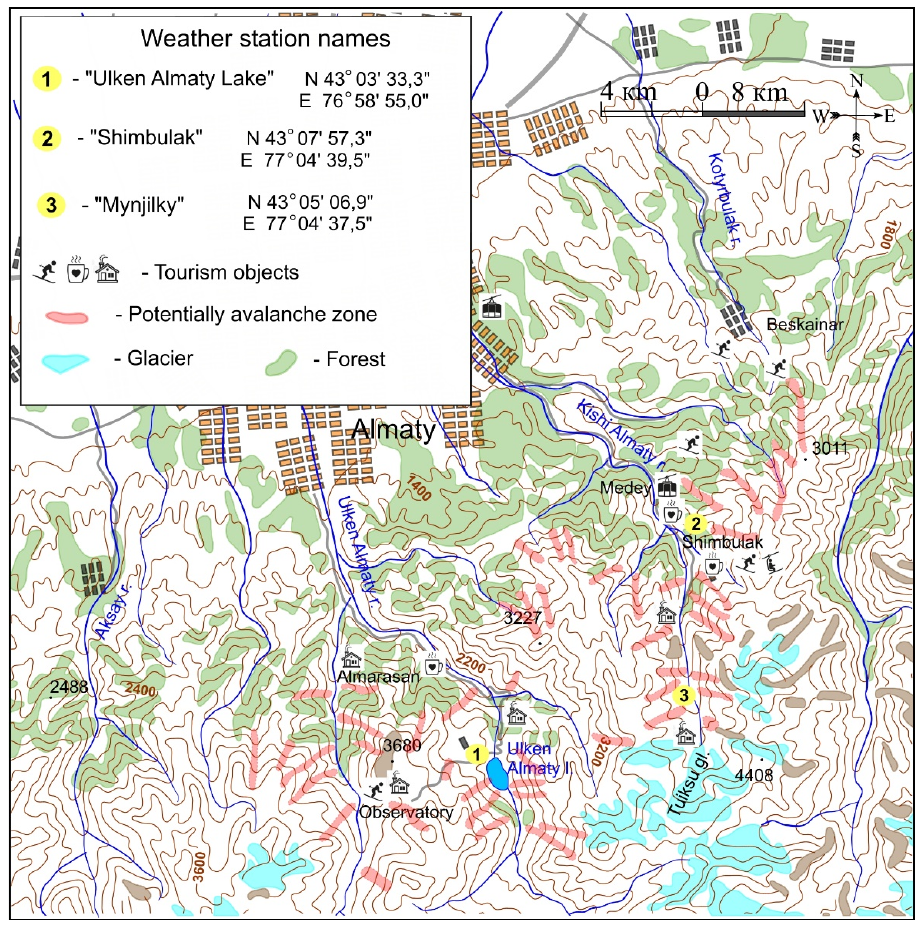
Figure 1. Study area.